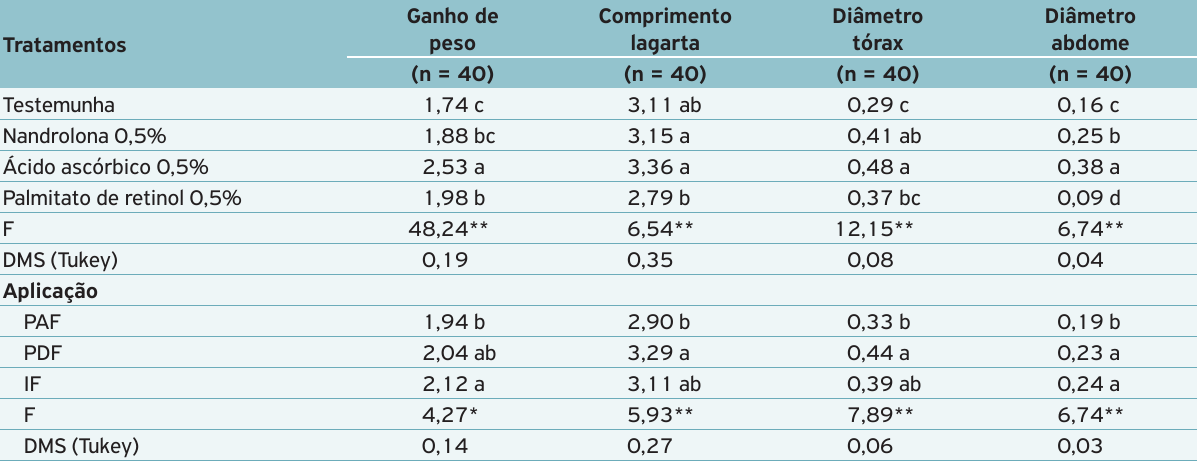
Tabela 1. Ganho de peso (g), comprimento (cm), diâmetro de tórax (cm) e diâmetro de abdome (cm) de lagartas de 5º ínstar de Bombyx mori L. alimentadas com folhas de amoreira contendo diferentes aditivos, em três métodos de aplicação.